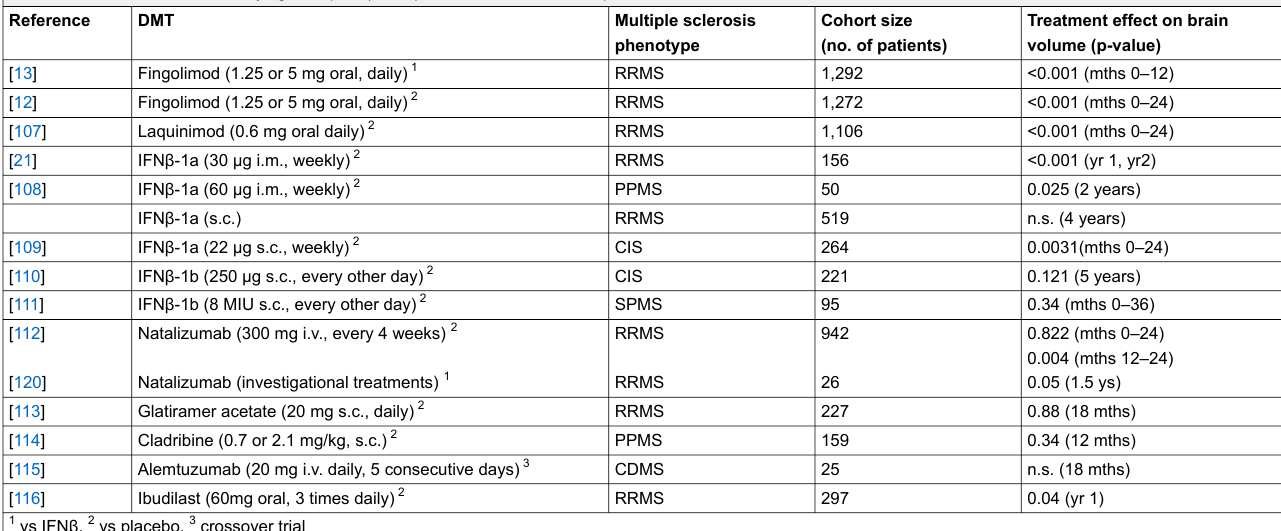
Table 3: Effects of disease-modifying therapies (DMTs) on brain volume in multiple sclerosis. Reference DMT Multiple sclerosis